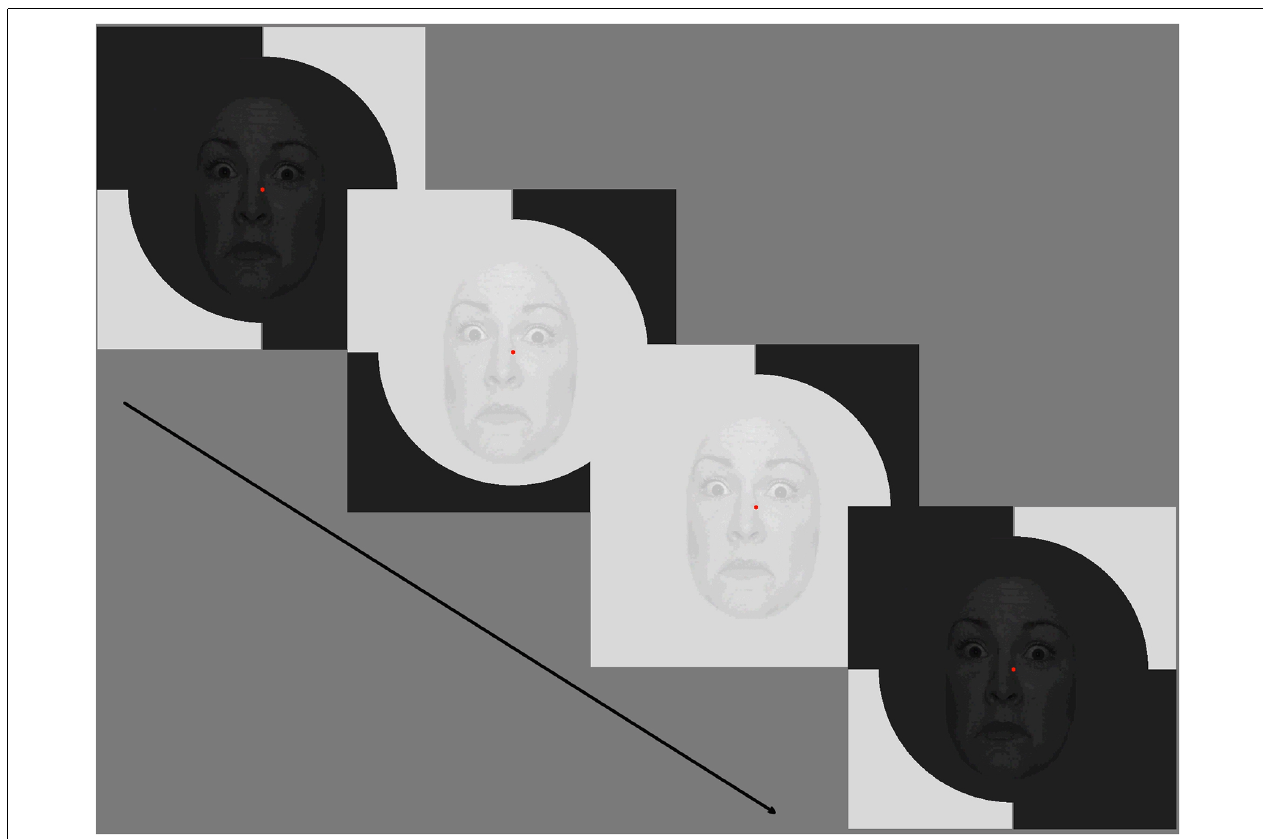
FIGURE 1 | Example of a fearful condition with 70% temporal modulation. Stimuli comprised of pseudorandom brightening/darkening of fearful, happy, neutral faces (or no face) with surround patches decorrelated from the central face-bearing patch. For the central patch, the spatial contrast of the faces was 30% while the temporal contrast of the per-pixel luminance increment/decrement was 10% or 70%. Note that for each condition (happy, fearful, neutral) faces of different actors changed every second, but maintained emotional state. Consent was obtained for the use of NimStim